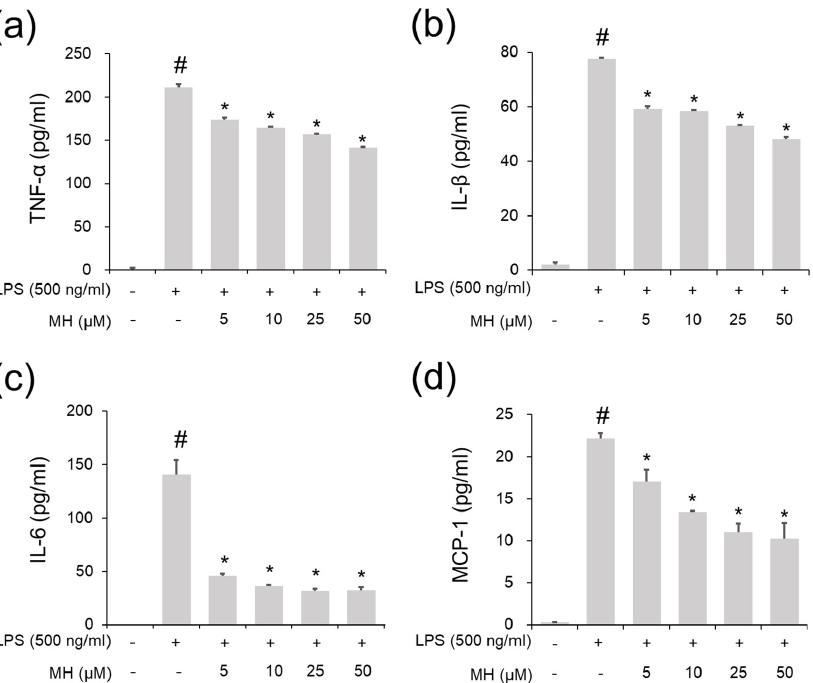
Figure 4. Effects of MH on secretion of cytokines and chemokines in LPS − stimulated RAW264.7 cells. Cells were treated with MH (5, 10, 25, 50, and 100 μ M) 1 h prior to incubation with 500 ng/mL LPS for 18 h. ( a – d ) The levels of TNF −α , IL − 1 β , IL − 6, and MCP − 1 were detected using ELISA kits. Data are expressed as the mean ± SD (n = 3) ( # p < 0.05 for comparison with control; * p < 0.05 for comparison with 500 ng/mL LPS).